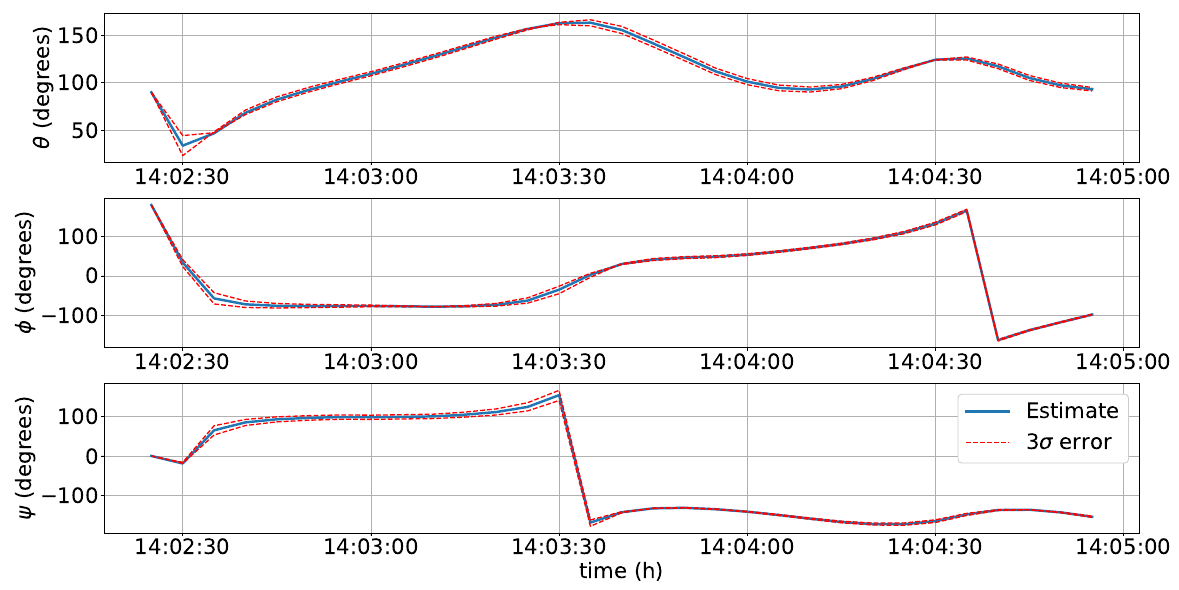
Figure 10. Euler angles from attitude reconstruction. Since the AlfaCrux satellite does not have an attitude control subsystem, the only torques acting on the CubeSat are the disturbance ones, such as those due to the gravity- gradient and residual magnetic dipole. For these first analyses, the influence of a possible residual magnetic dipole was not considered. This will be estimated later along with the magnetometer data analysis and calibration. By using the least squares method, it was possible to estimate an initial magnetometer bias with an order of magnitude of 10 4 nT. With respect to the solar panels, since they do not have available information about sensor characterization, the uncertainties must be estimated. As regular coarse sensors are inaccurate in the order of degrees, the same order of magnitude is expected for the estimation of the Sun vector direction based on the power and thermal analysis. Finally, the evolution of the state error standard deviations can be calculated, providing the results shown in Figure 11.